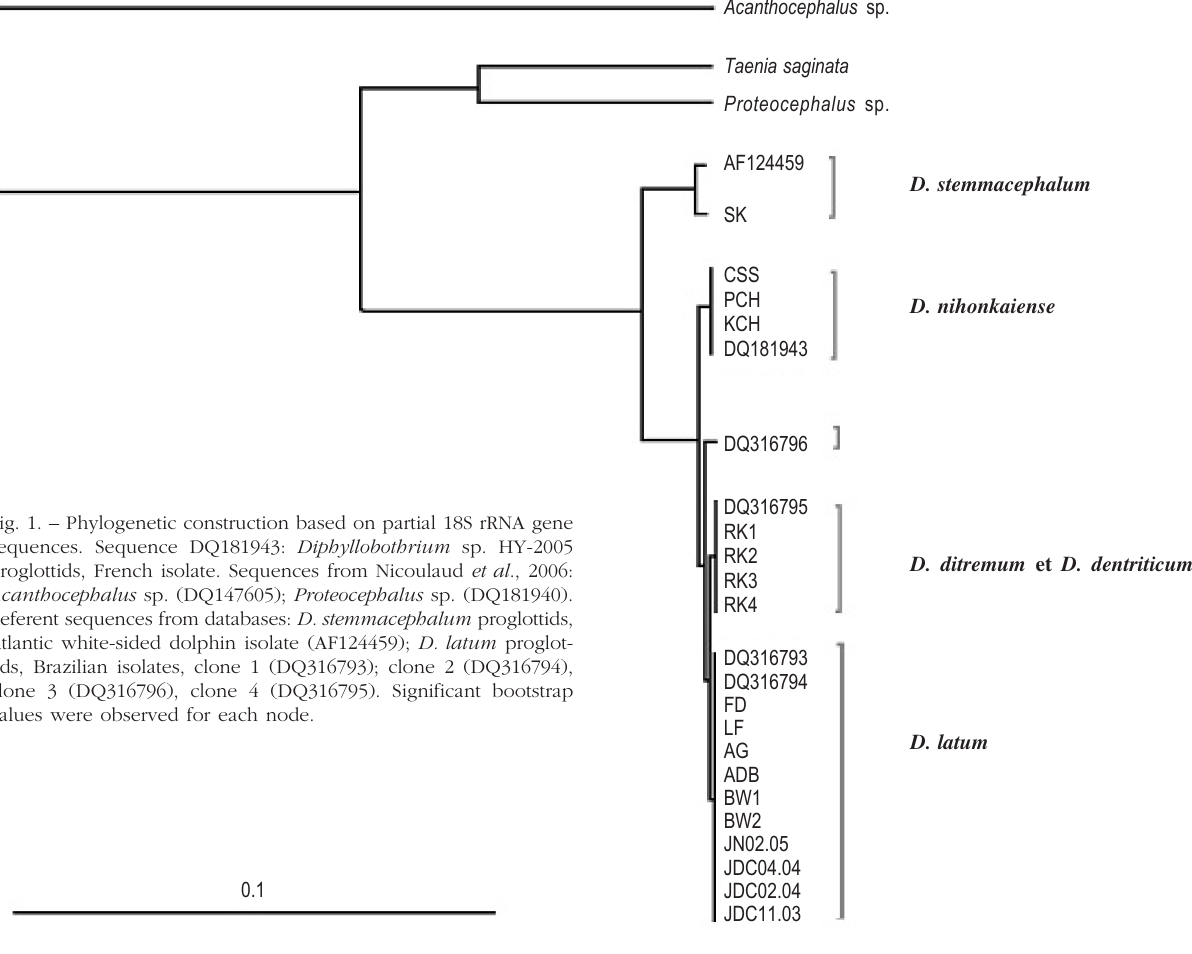
Fig. 1. – Phylogenetic construction based on partial 18S rRNA gene sequences. Sequence DQ181943: Diphyllobothrium sp. HY-2005 proglottids, French isolate. Sequences from Nicoulaud et al ., 2006: Acanthocephalus sp. (DQ147605); Proteocephalus sp. (DQ181940). Referent sequences from databases: D. stemmacephalum proglottids, Atlantic white-sided dolphin isolate (AF124459); D. latum proglot- tids, Brazilian isolates, clone 1 (DQ316793); clone 2 (DQ316794), clone 3 (DQ316796), clone 4 (DQ316795). Significant bootstrap values were observed for each